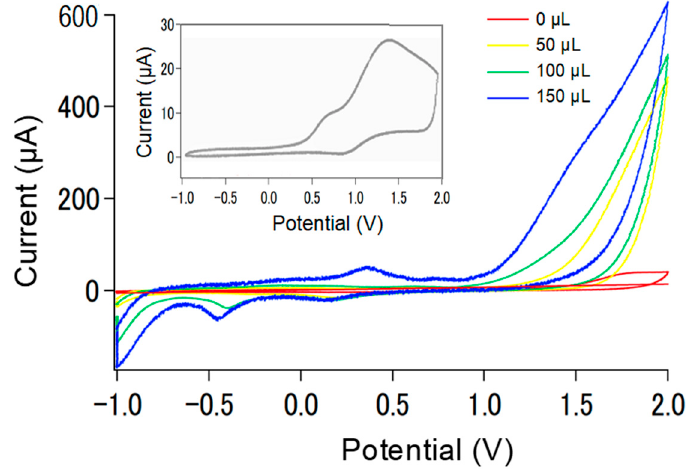
Figure 3. Cyclic voltammograms of Fe(salen)-PPy NPs in acetonitrile at 25 ◦ C. Complex concentration: 0.001 M; supporting electrolyte: 0.1 M TBAP; scan rate: 100 mV/s; working electrode: Pt sphere; reference electrode: Ag/Ag+. The inset shows the CV of Fe(salen).